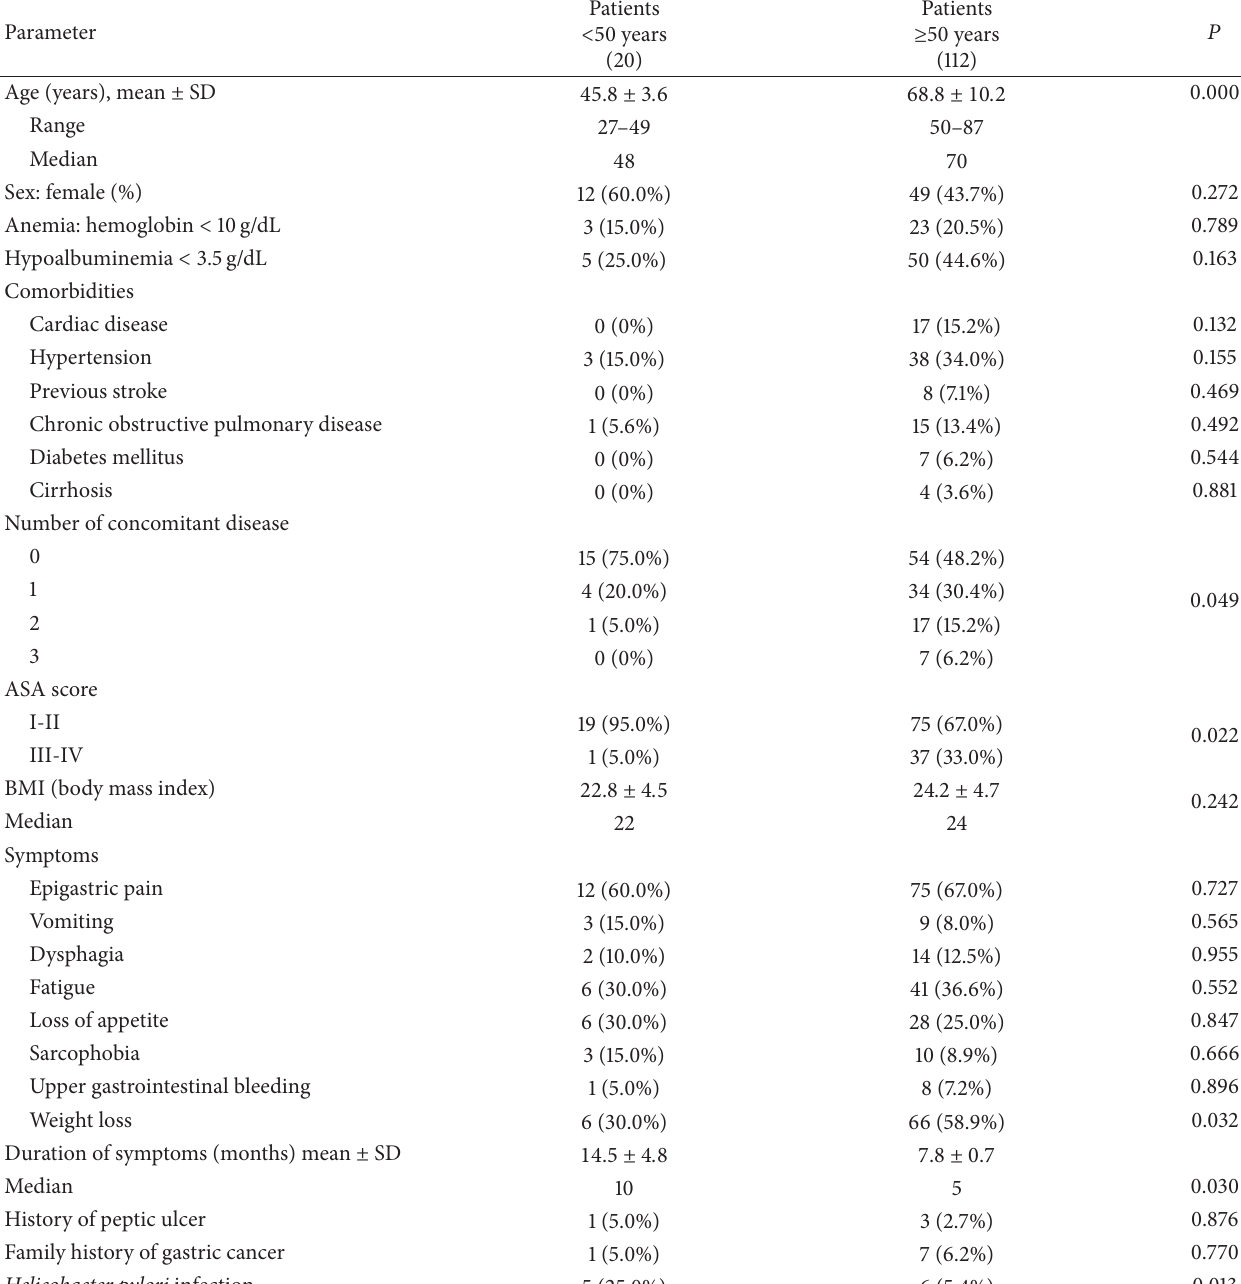
Table 1: Characteristics and preoperative abnormalities of patients with gastric